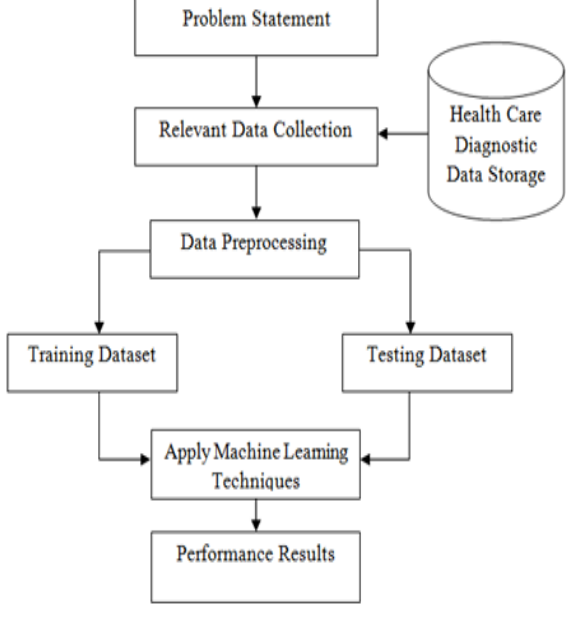
Figure 4. The overall process of our work.